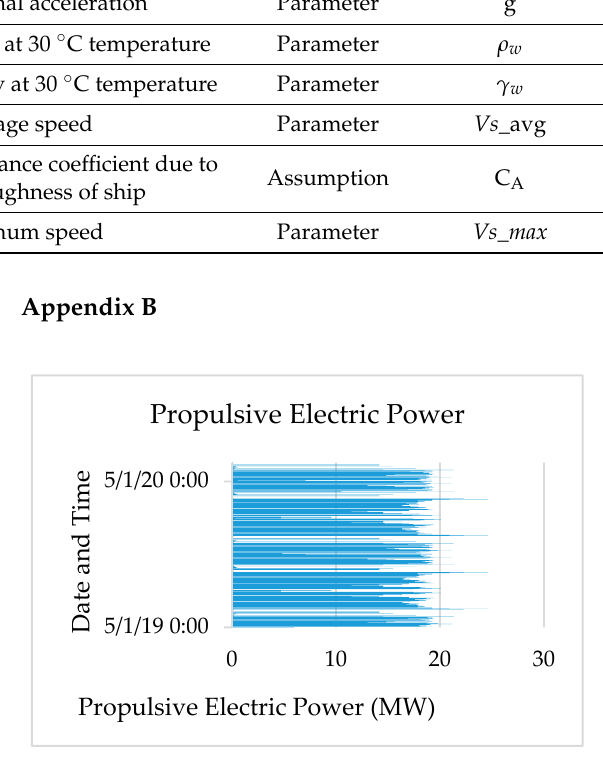
Figure A1. Ship Propulsive Power Requirement (Yearly).